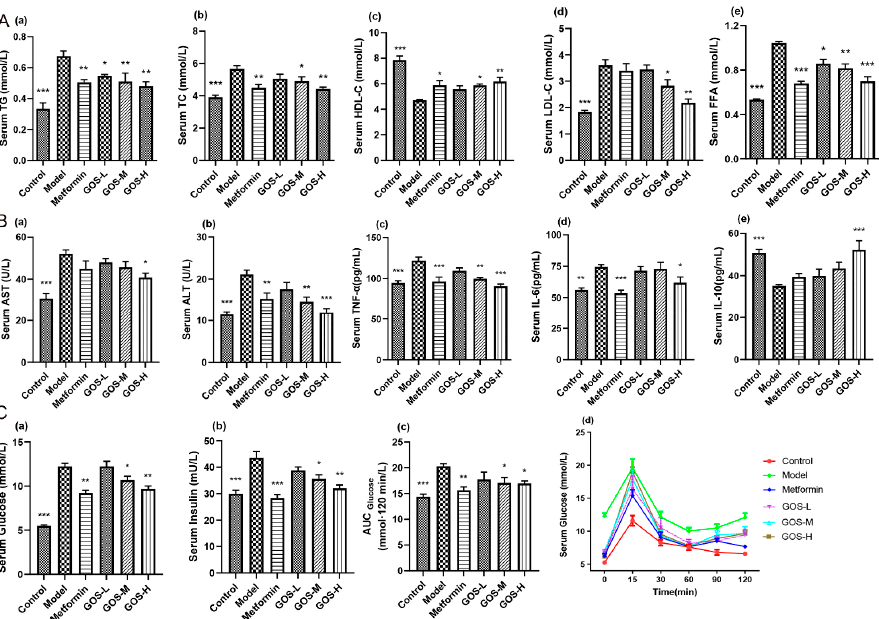
Figure 3. ( A ) Changes of TC ( a ), TG ( b ), HDL-C ( c ), LDL-C ( d ), and FFA ( e ) in serum of mice after administration ( n = 10, mean ± SEM). ( B ) Changes in serum AST ( a ), ALT, ( b ) TNF- α ( c ), IL-6 ( d ), and IL-10 ( e ) of mice after administration ( n = 10, mean ± SEM). ( C ) Changes of fasting blood glucose ( a ) and insulin in mice after administration ( b ) ( n = 10, mean ± SEM). Changes in glucose tolerance of mice after administration ( n = 6, mean ± SEM): ( c ) Blood glucose changes over time; ( d ) Area under GLU. Note: * p < 0.05, ** p < 0.01, *** p < 0.001 vs. the model group.